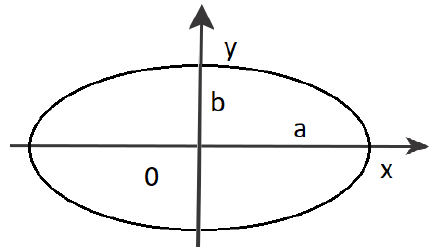
Figure 2. The model of the form changes for circular pores in elongated TM. So, the concentration of stress on the pores and its evolution are significant factors in the deformation and fracture of